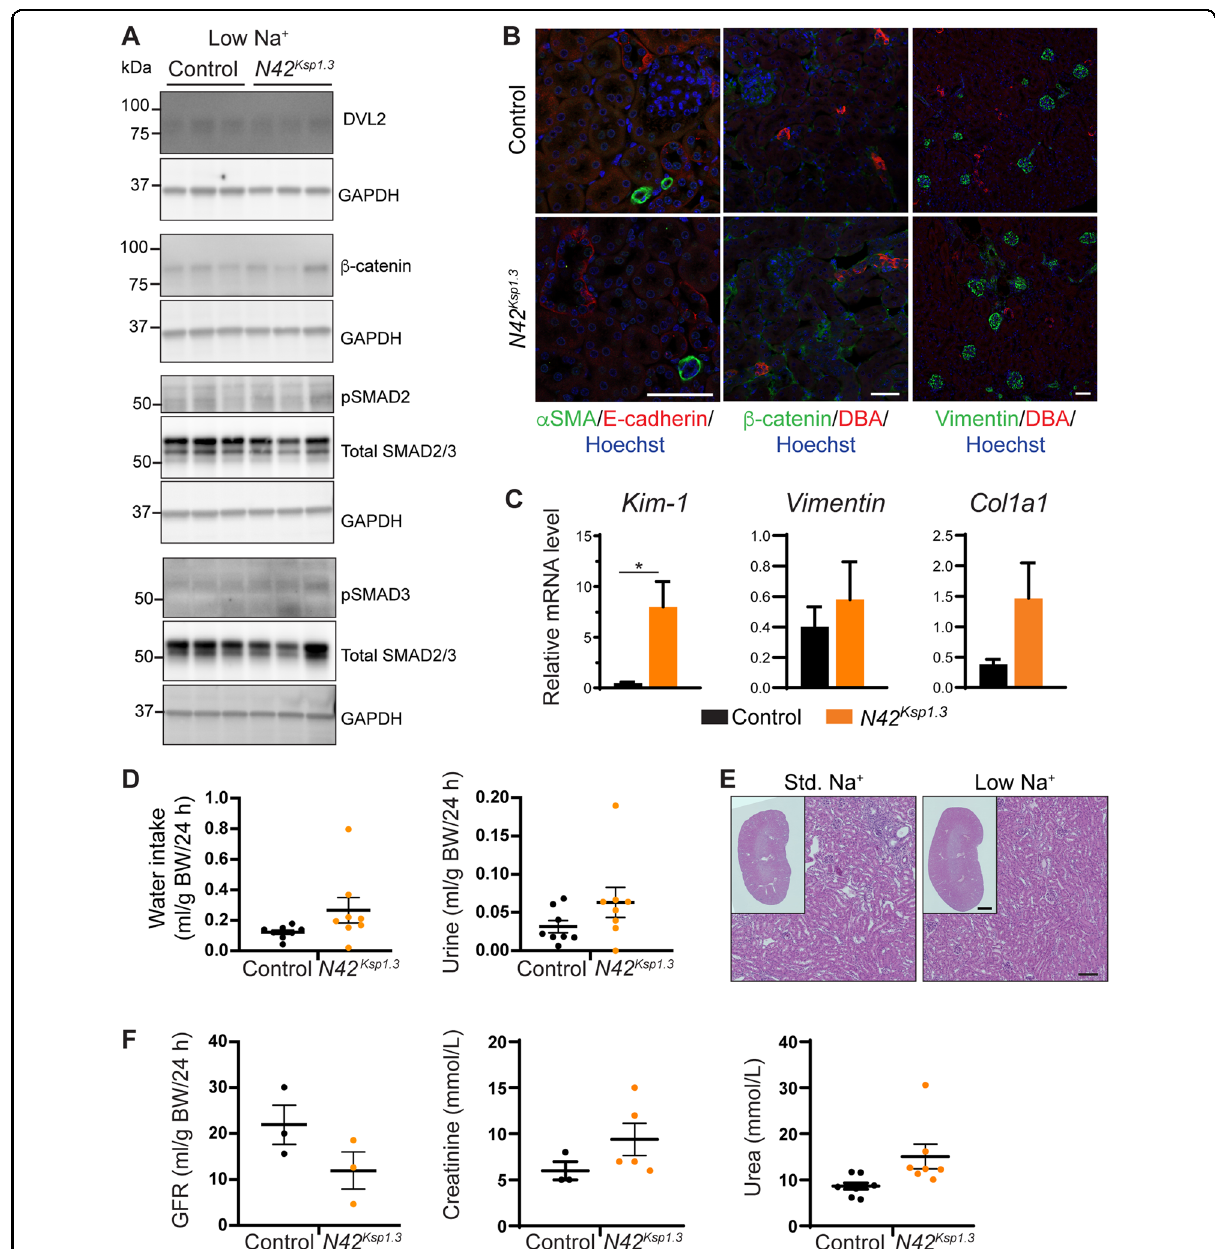
Fig. 7 Low dietary Na + ameliorates Wnt/ β -catenin/TGF- β signaling and kidney disease in Nedd4-2 Ksp1.3 mice. Mice were fed a low Na +